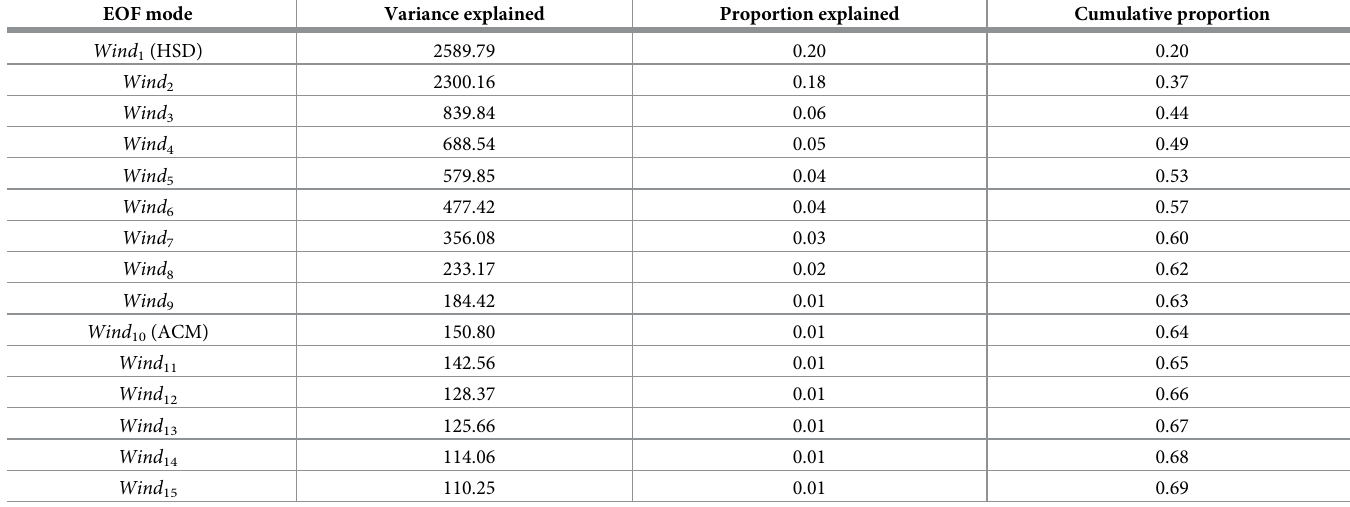
correlation matrix for the three wind components. Next, we perform the EOF analyses [69] separately for each of the two correlation matrices. This leads us to retain 15 atmospheric EOF modes from each group that explain respectively about 83% and 69% of the total vari- ability of the TRH and WC variables (Tables 2 and 3). Thus, we have EOF modes with com- mon interpretation (the same loadings) over the four regions capturing the dependence among the original variables. In addition, each of the four regions has its own calculated EOF modes. That is, the loadings are the same across the study regions but the calculated EOFs are specific to each region. Those EOF modes are data-driven, non subjective indices where each EOF mode is a three-dimensional weighted average of the meteorological Table 3. Summary of the explained variance, proportion of variability explained be each wind component mode as well as the cumulative proportions. The Wind the i th EOF mode of the wind group. EOF mode Variance explained